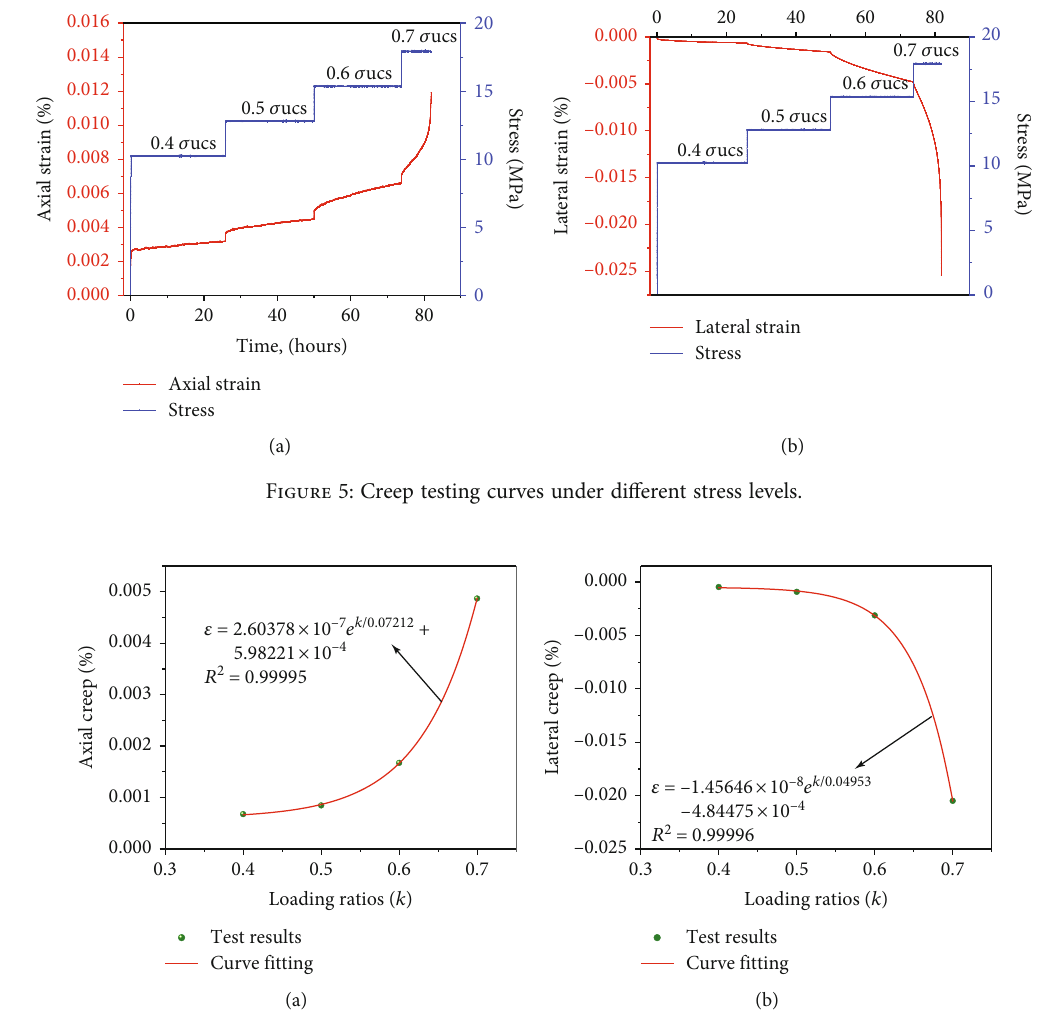
Figure 6: Creep testing curves under di ff erent stress levels.